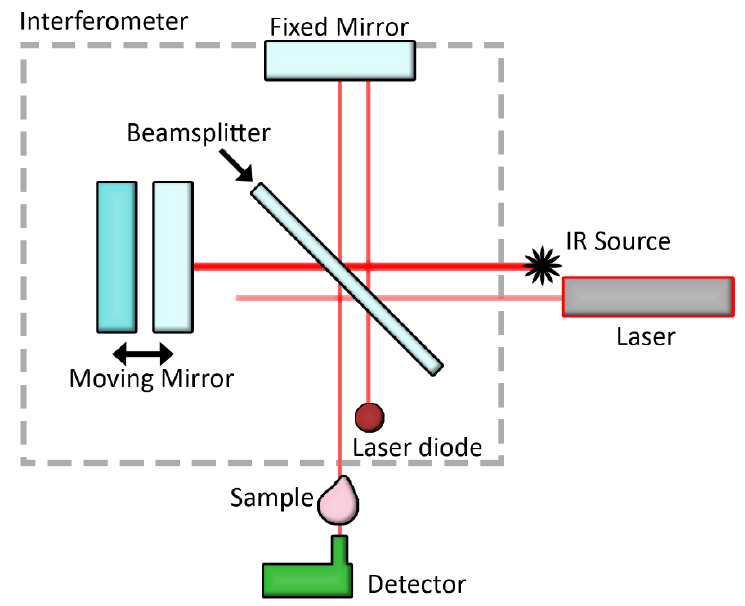
Figure 1. Scheme of a Fourier transform infrared spectrometer.